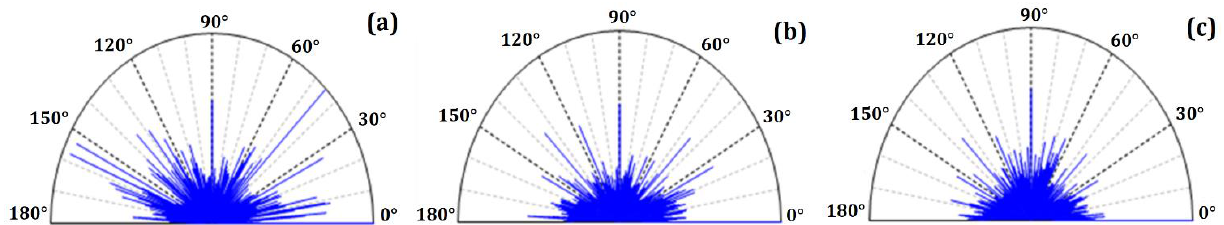
Table 4. Surface texture isotropy (STI) and the respective directions.